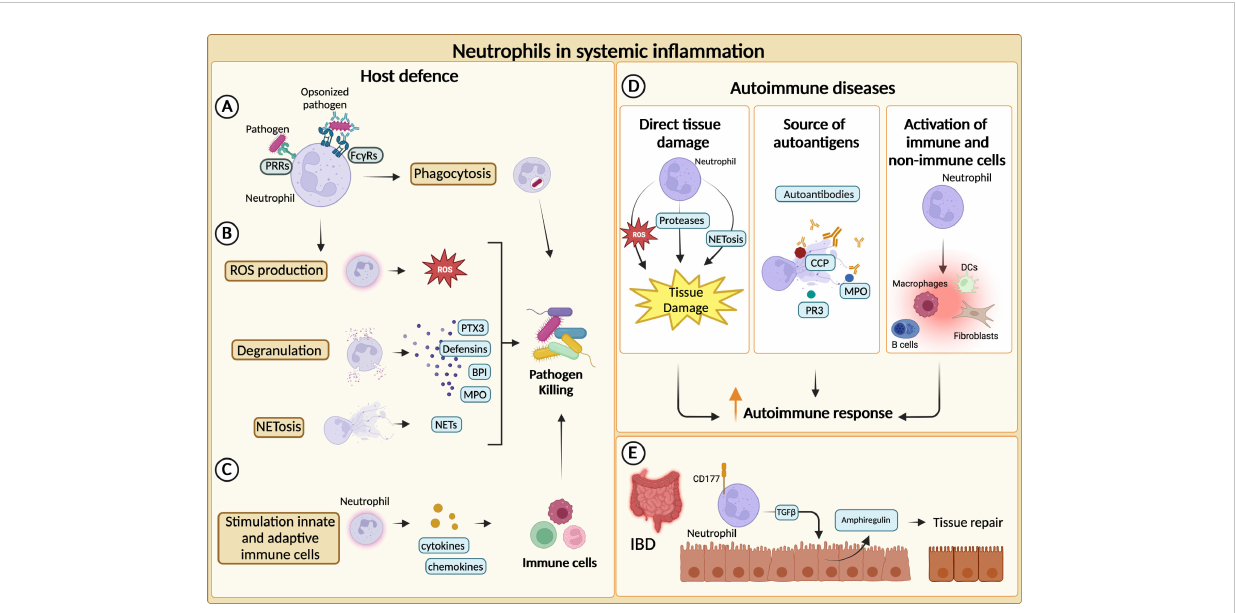
FIGURE 2 Neutrophils in systemic in fl ammation. (A) Neutrophils phagocytize and kill pathogens by using Fc g receptors (Fc g Rs) and pathogen recognition receptors (PRRs) for the engulfment of opsonized or non-opsonized pathogens. (B) Neutrophils can eliminate pathogens through degranulation, production of reactive oxygen species (ROS) and release of neutrophil extracellular traps (NETs). (C) Neutrophils actively recruit and activate other innate and adaptive immune cells ensuring a complete clearance of the pathogens. (D) Neutrophils can fuel the autoimmune response and exacerbate tissue-damaging in fl ammation through various mechanisms. First, they can directly cause tissue damage. NETs-associated molecules, such as cyclic citrullinated peptides (CCP), myeloperoxidase (MPO) and proteinase 3 (PR3), can represent an important source of autoantibody targets. Neutrophils promote autoimmune response by recruiting and activating adaptive and innate immune cells as well as non-immune cells. (E) In in fl ammatory bowel diseases (IBD), CD177 + neutrophils producing TGF b stimulate the production of the tissue repair-promoting factor amphiregulin (AREG) by intestinal epithelial cells and promote tissue